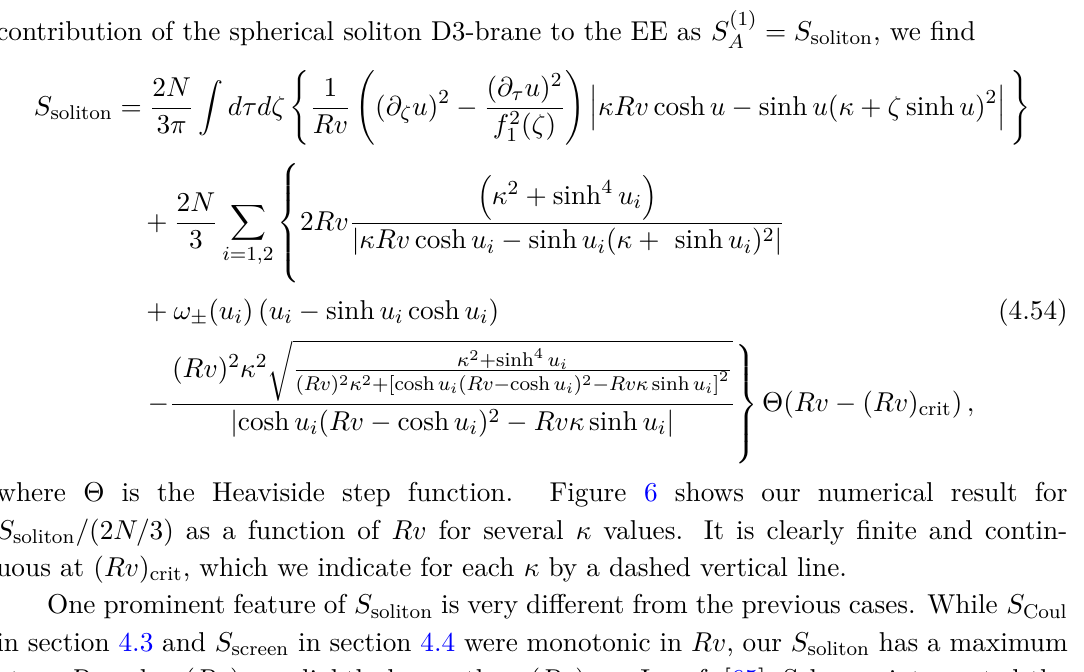
Figure 6 . Our numerical results for S soliton / (2 N/ 3) in eq. (4.54) as a function of Rv for (from left to right) κ = 1 (blue), 2 (green), 3 (purple), 4 (orange), 5 (red). The dashed vertical lines denote the location of the critical radius Rv = ( Rv ) crit defined in eq. (4.46). Each curve also has a maximum at ( Rv ) max & ( Rv ) crit